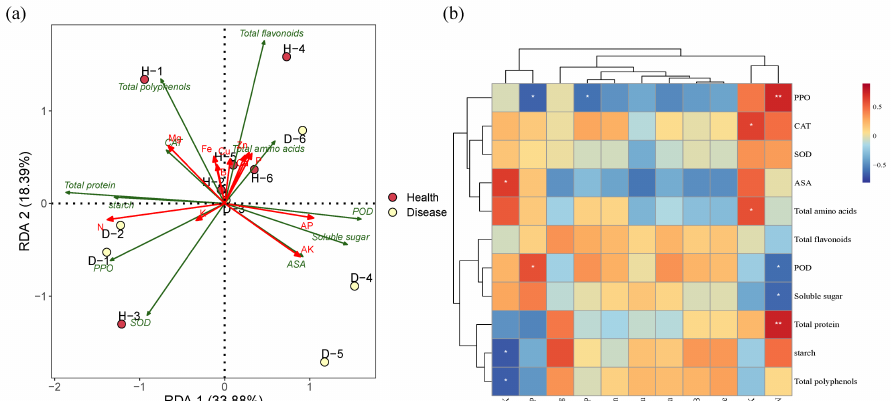
Figure 5. Correlation of nut characteristics with soil elements. ( a ) Redundancy analysis (RDA). The color ranges of red and green lines ( a ) represented positive and negative correlation, respectively; ( b ) Pearson correlation heatmap. * and ** represented the significance at 0.05 and 0.01 levels,